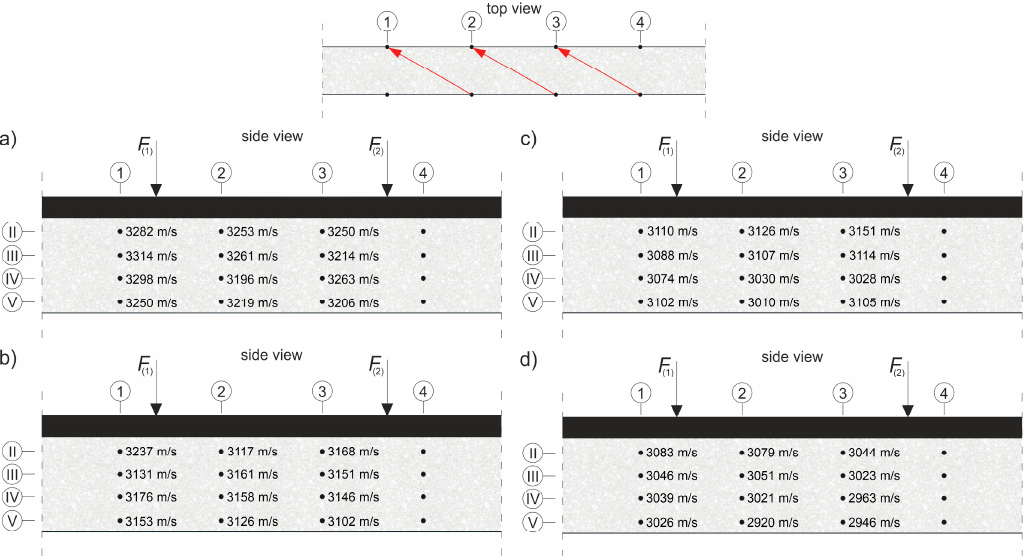
Figure 31. Velocities of the longitudinal waves in beam #2 propagating between the sending and receiving points situated diagonally with one point offset in the left direction, before: ( a ) stage 1, ( b ) stage 2, ( c ) stage 3, ( d ) stage 4.